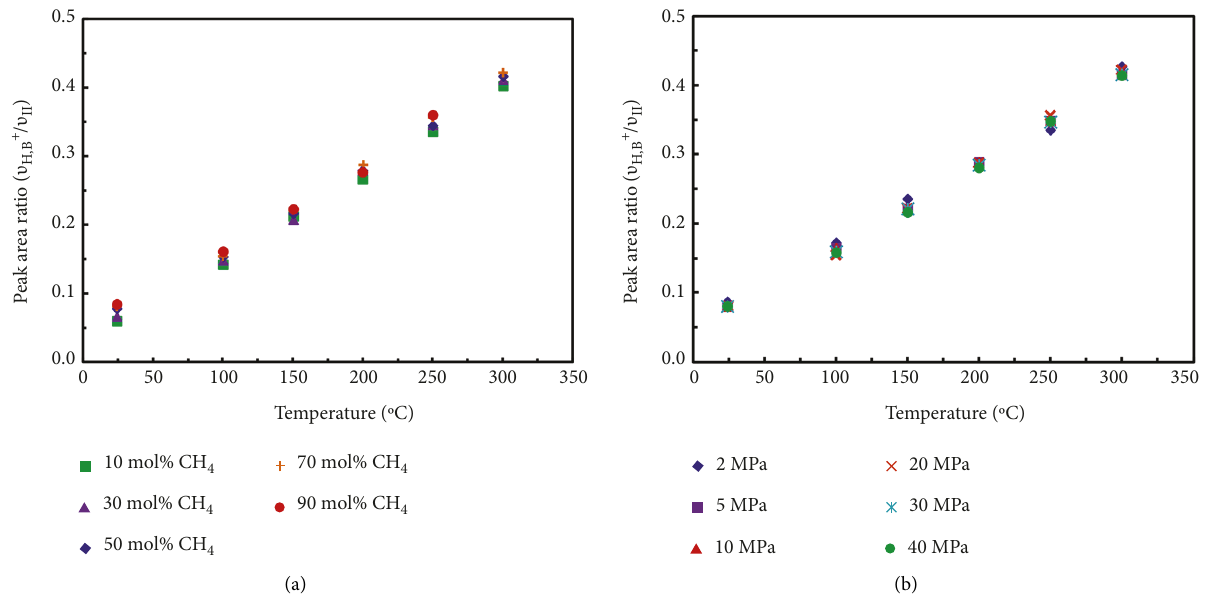
Figure 13: (a) Raman peak area ratio between the upper hot band and the upper Fermi domain versus temperature at 20MPa for different CO 2 -CH 4 mixtures. (b) Raman peak area ratio between the upper hot band and the upper Fermi domain versus temperature at 70% CH 4 - 30% CO 2 and different